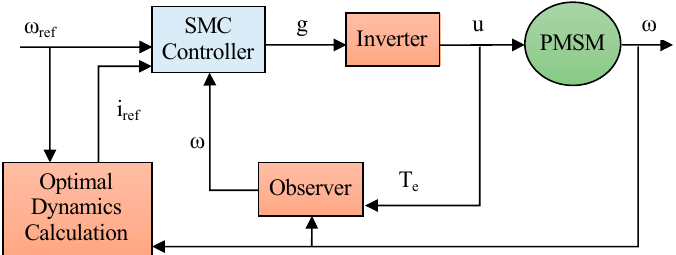
Figure 4. Basic structure of the PMSM SMC control.